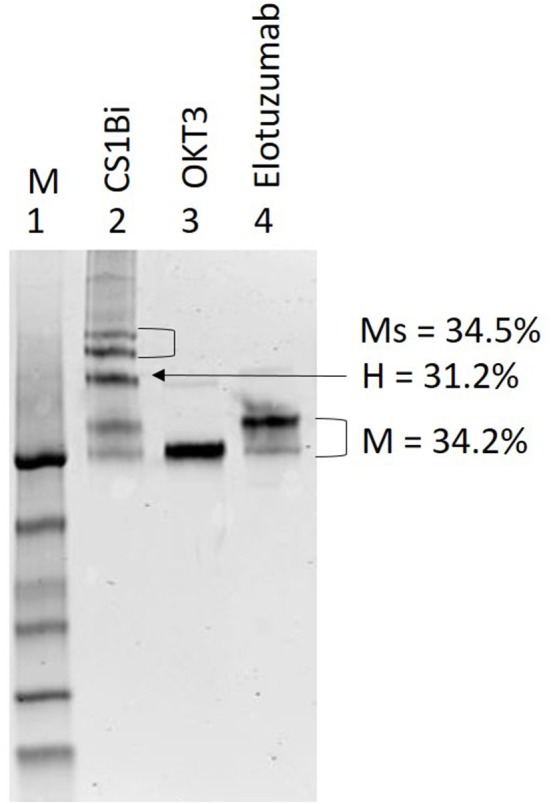
SDS-PAGE of CS1Bi heteroconjugation product. Lane 1: molecular weight markers; Lane 2: CS1Bi product containing unconjugated monomers, heterodimer, and multimers forms; Lane 3: OKT3; Lane 4: elotuzumab. M, monomers; H, heterodimers; Ms, multimers.